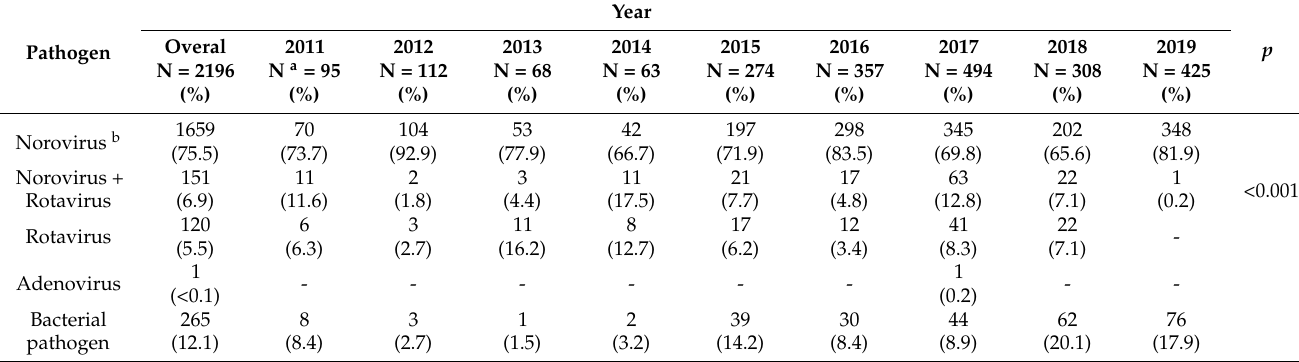
Table 2. Characteristics of pathogens causing diarrhea clusters in Taiwan,